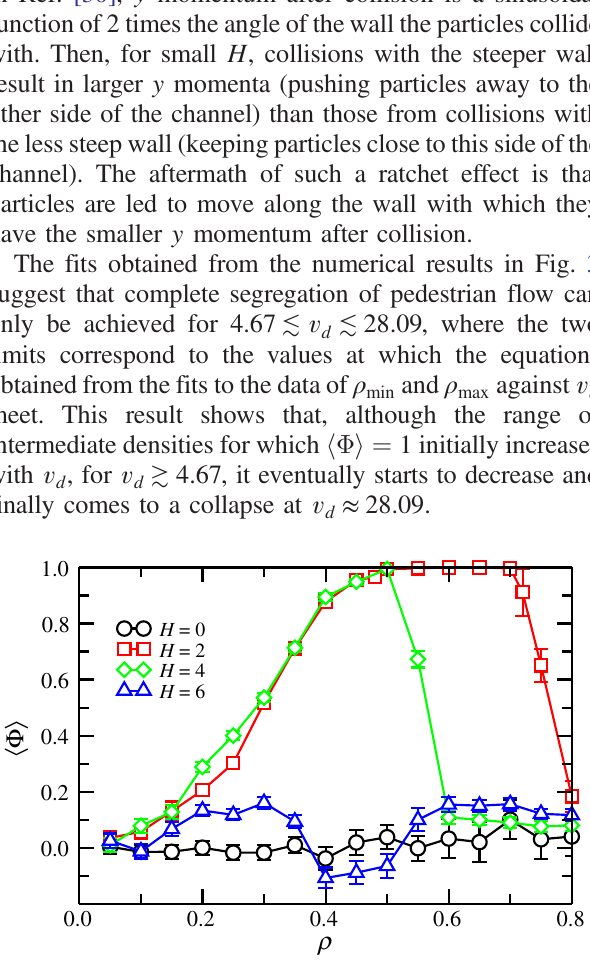
FIG. 4. Average order parameter as a function of the particle ¼ 6 , and various values of the depth density, for θ ¼ 0 , b ¼ 8 , v d H of the serrated